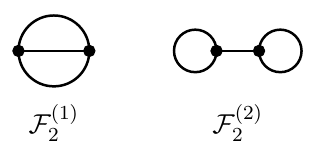
Figure 3 . Feynman diagrams for